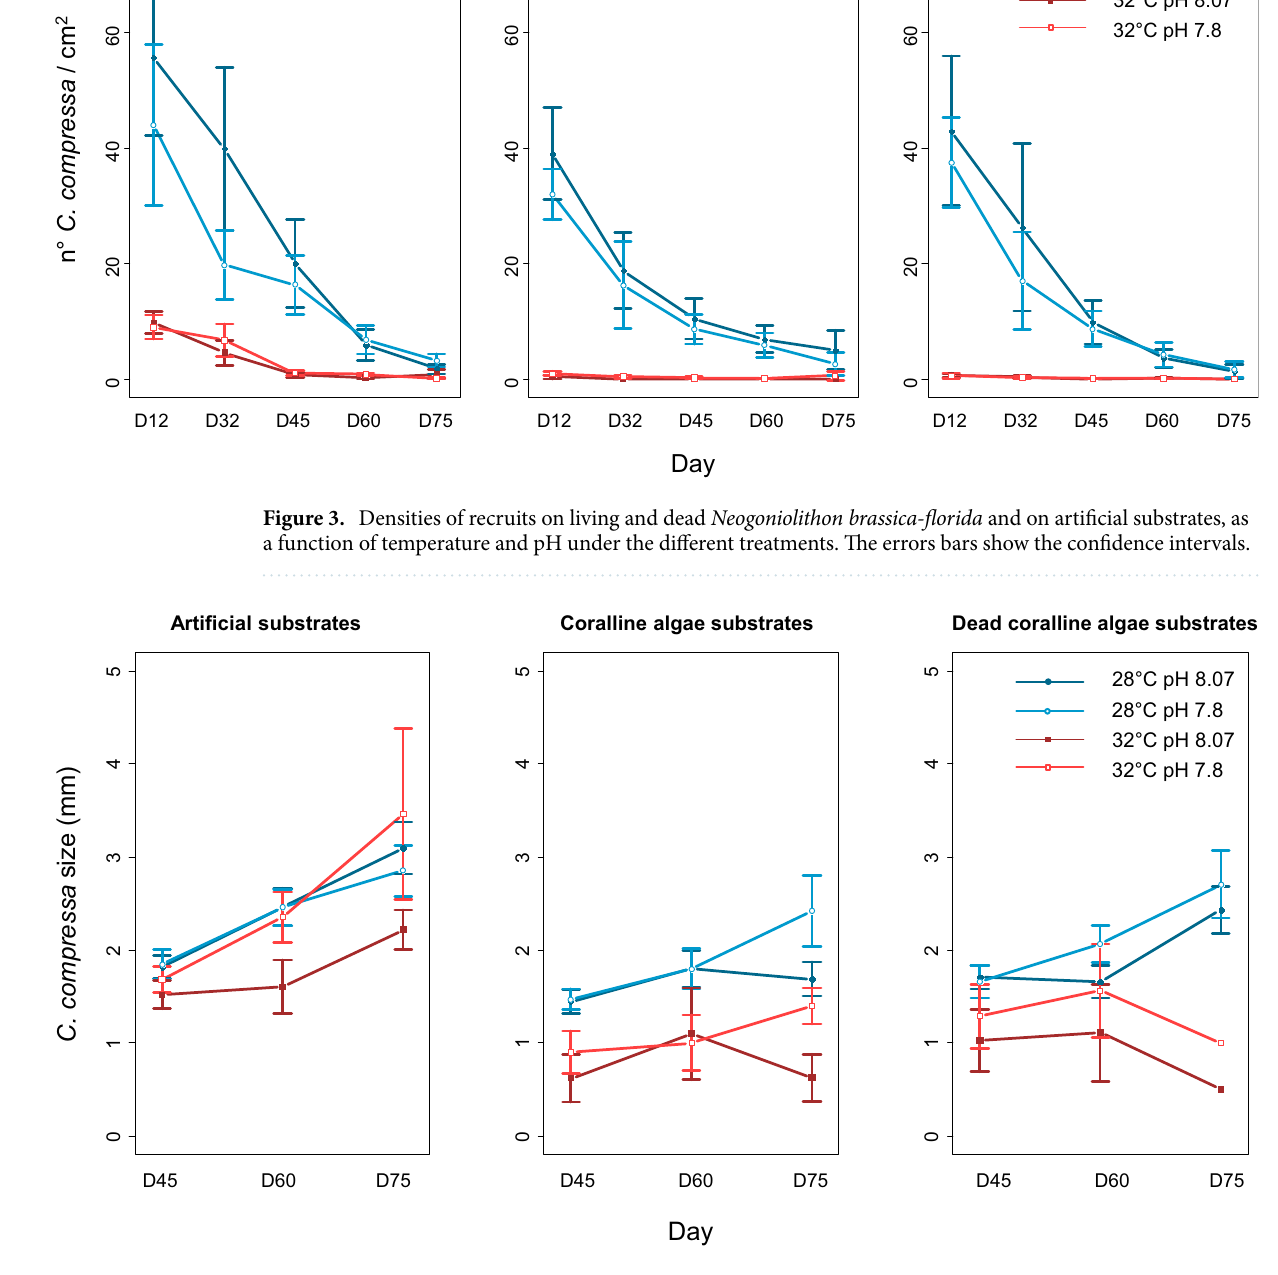
Figure 4. Size of recruits on living and dead Neogoniolithon brassica-florida and on artificial substrates as a function of temperature and pH under the different treatments. The errors bars show the confidence